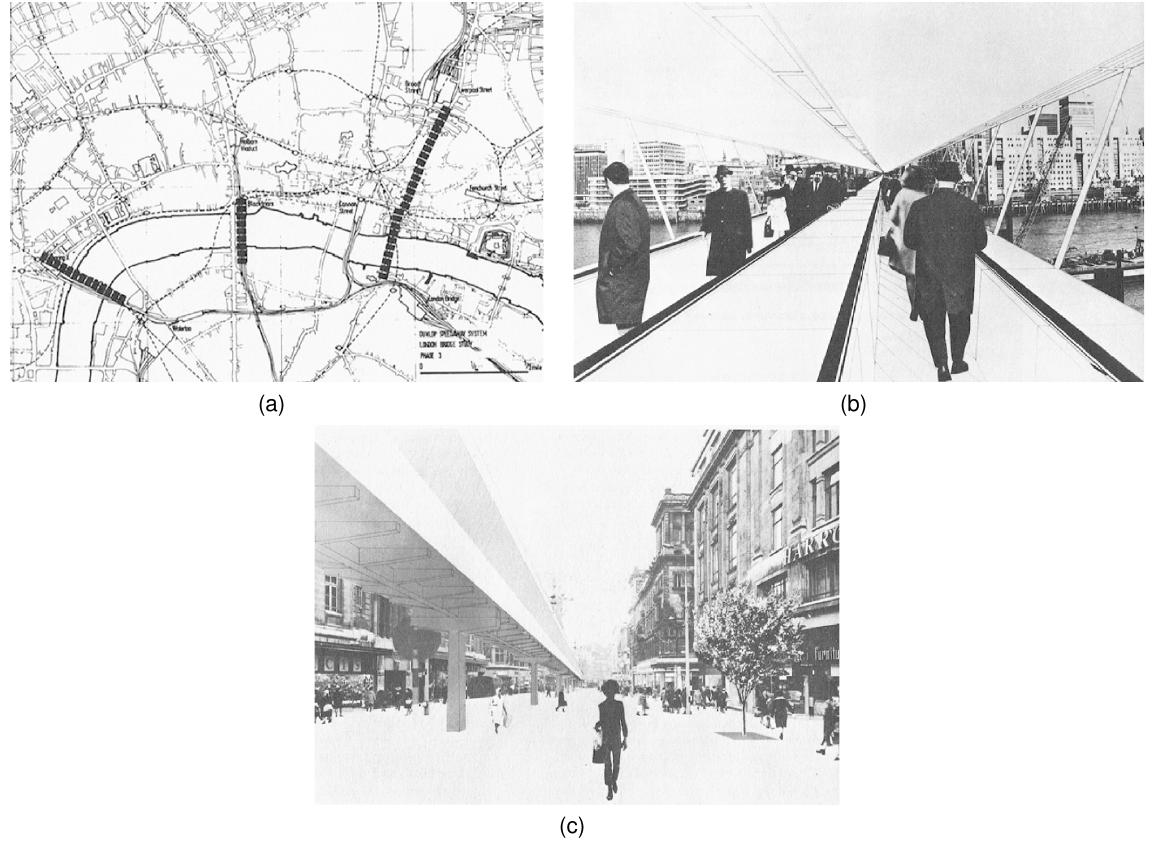
Figure 2. Speedaway system. (a) Plan showing the Speedaway system crossing the Thames connecting existing underground stations on the north bank with new developments on the south bank. (b) Interior view along the system. (c) Speedaway running above a car-free shopping street. Adapted from Richards